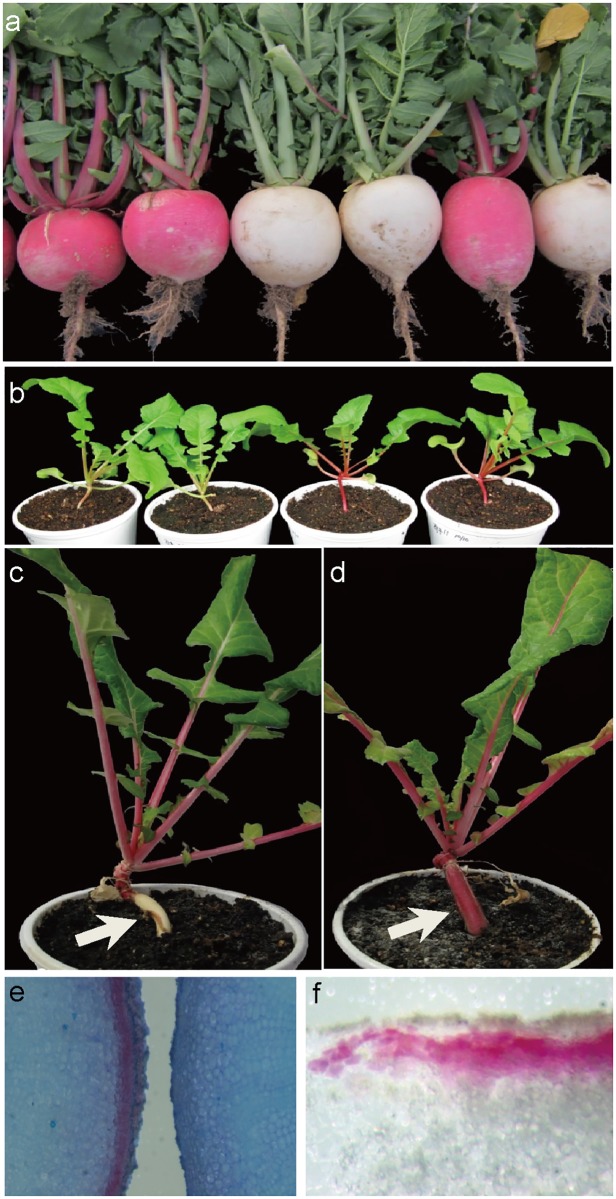
Phenotypes of red and white root skin radishes.(a) Root skin color phenotypes of segregating F2 individuals grown in a field. (b) Hypocotyl skin colors of F3 plants at 21 days after planting (DAP). Note that in many instances, the hypocotyl and petiole colors are already separated but they are not always identical to the root skin color. (c, d) White and red root skin colors of F3 plants at 120 DAP, when root and hypocotyl thickening is in progress (e) Stereomicroscopic images of transverse sections of the red (left) and white (right) roots stained with toluidine blue O. Samples are from the plants shown in (c) and (d). (f) Accumulation of anthocyanin pigments in the 2–4 layers of the subepidermal cells of red colored root (from c).